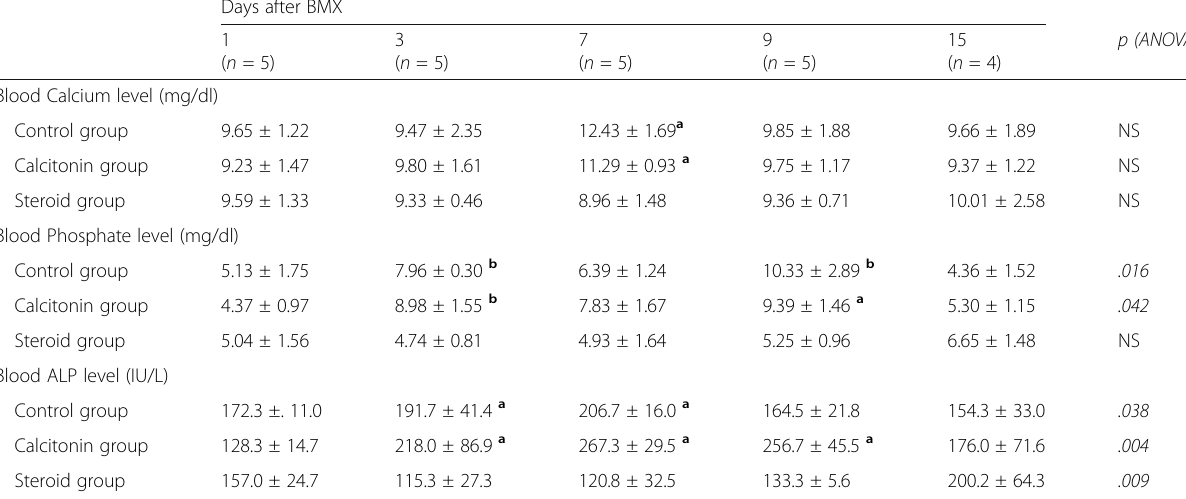
Table 1 Results of serum calcium, phosphate and ALP values after